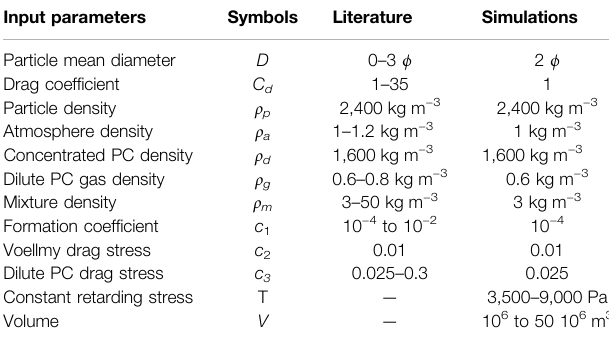
TABLE 3 | Input parameters of the two-layer VolcFlow model used for all simulations. The fi rst ten rows refer to fi xed input values de fi ned from previous numerical studies (Kelfoun et al., 2017;Gueugneauet al.,2019; Gueugneau et al., 2020).The last two rows refer toparameterswhich varied inthe simulationswithin the range of values